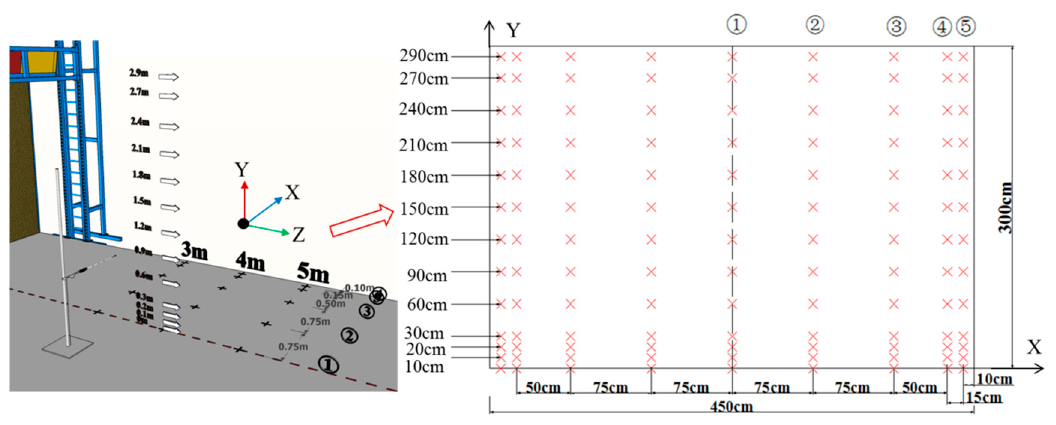
Figure 4. A sketch of the measuring method.